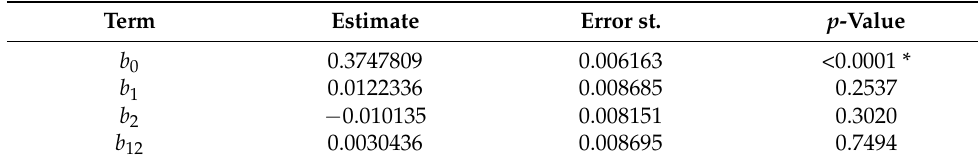
Table 3. Estimated unknown parameters of Equation (3) for Faraday efficiency ( Ω D ), together with corresponding standard errors and p -values. Asterisk indicates statistical significance ( α = 0.05). Term Estimate Error st. p -Value b 0 0.3747809 0.006163 b 1